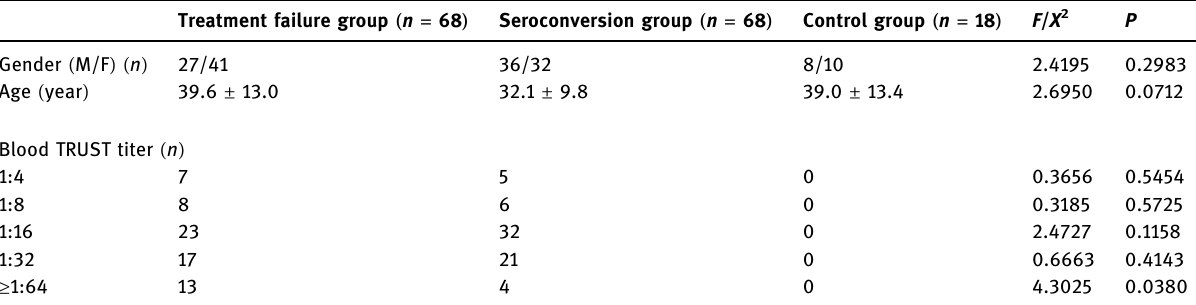
Table 1: Patients ’ characteristics at baseline in three groups Treatment failure group ( n = 68